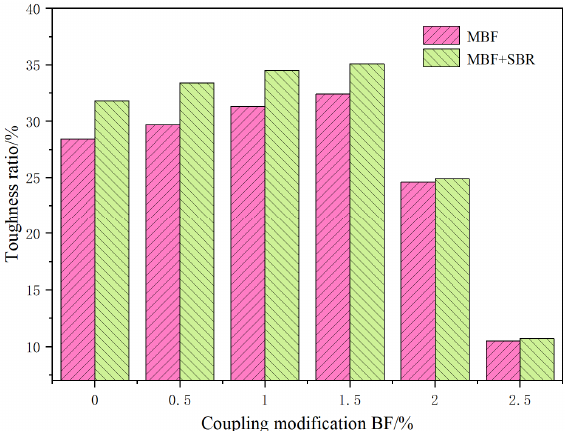
Figure 15. Toughness ratio R T/V diagram of coupling-modified BF evaporation residue. Table 6. Bending rheological parameters of MBF emulsified